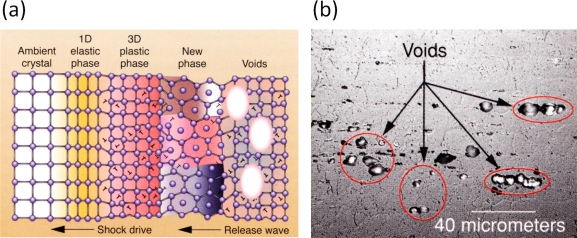
(a) Schematic of a crystal placed under shock loading. Initially it will compress uniaxially and then relax plastically through defects on the nanoscale, a process known as the one-dimensional to three-dimensional transition. The material may also undergo a structural transformation, represented here as a cubic to hexagonal change. The transformation occurs over a characteristic time scale. The new phase may be polycrystalline solid or melt. Once pressure is released, the microvoids that formed may grow, leading to macroscopic damage that causes the solid to fail. (b) This micrograph shows the voids that occur when a polycrystalline aluminium alloy is shocked and recovered. As the shock wave releases, the voids grow and may coalesce, resulting in material failure.